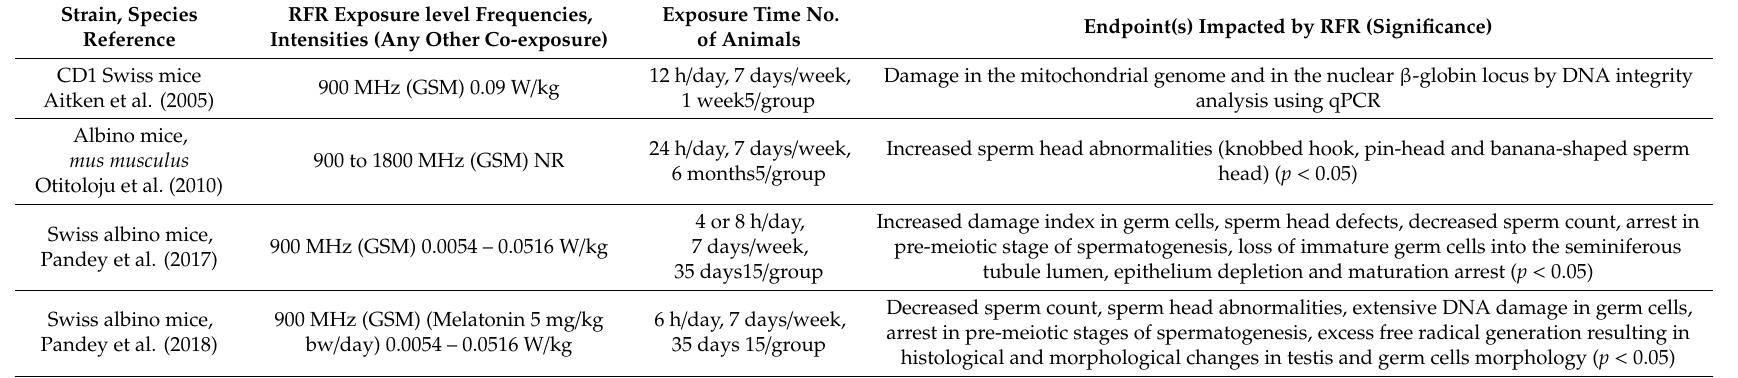
Table 5. Male reproductive studies in mice exposed to